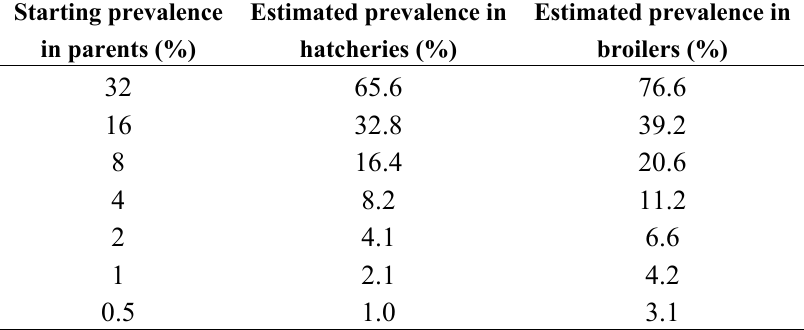
Table 2. Results of modelled flock prevalence in hatcheries and broilers, depending